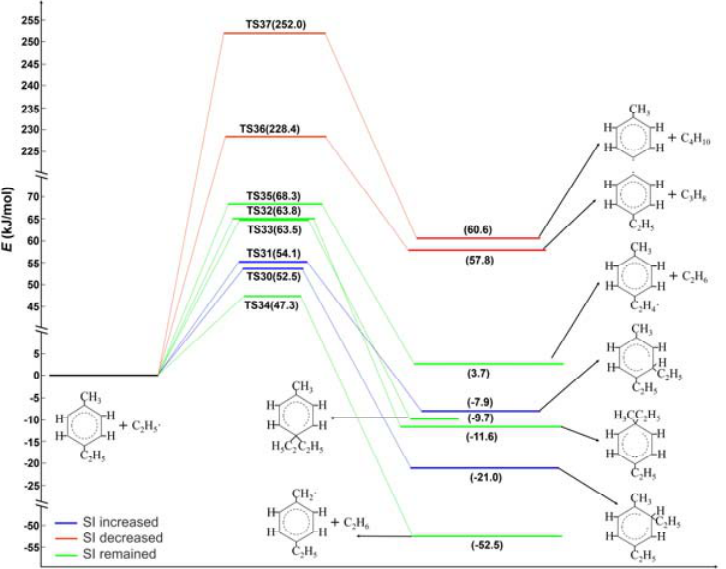
Figure 6. Energy profiles of the ethyl radical reacted with 4-ethyltoluene (SI: Substitution Index).